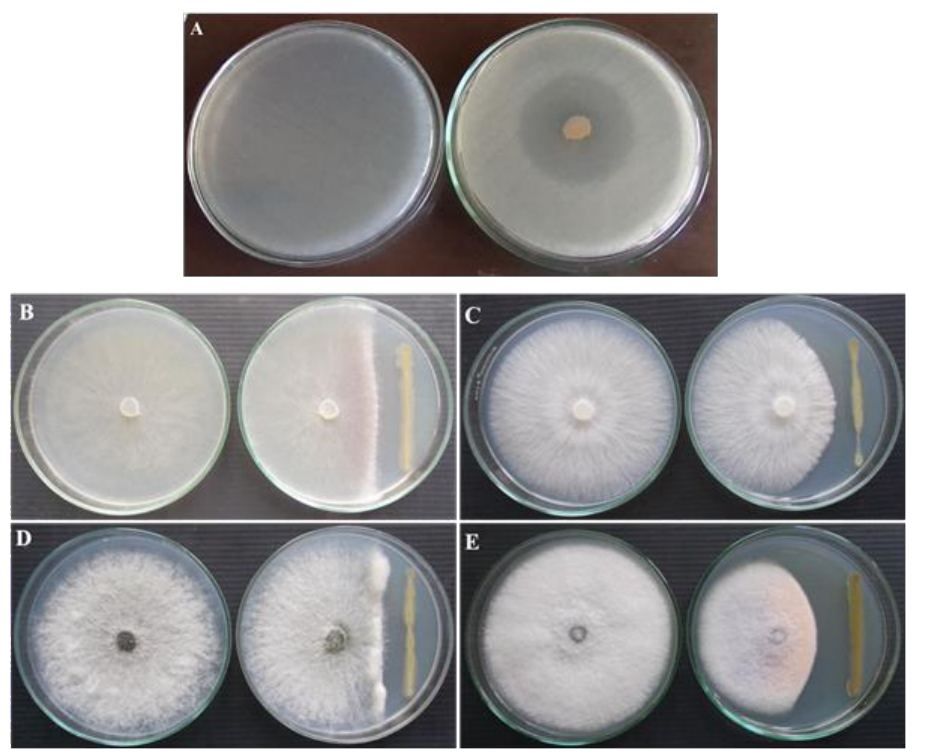
Figure 1. Antagonistic activity of P. fluorescens VSMKU3054 against plant pathogens by dual culture plate assay. ( A ) — P. fluorescens + R. solanacearum , ( B ) — P. fluorescens + R. solani , ( C ) — P. fluorescens + S. rolfsii , ( D ) — P. fluorescens + M. phaseolina and ( E ) — P. fluorescens + F. oxysporum.